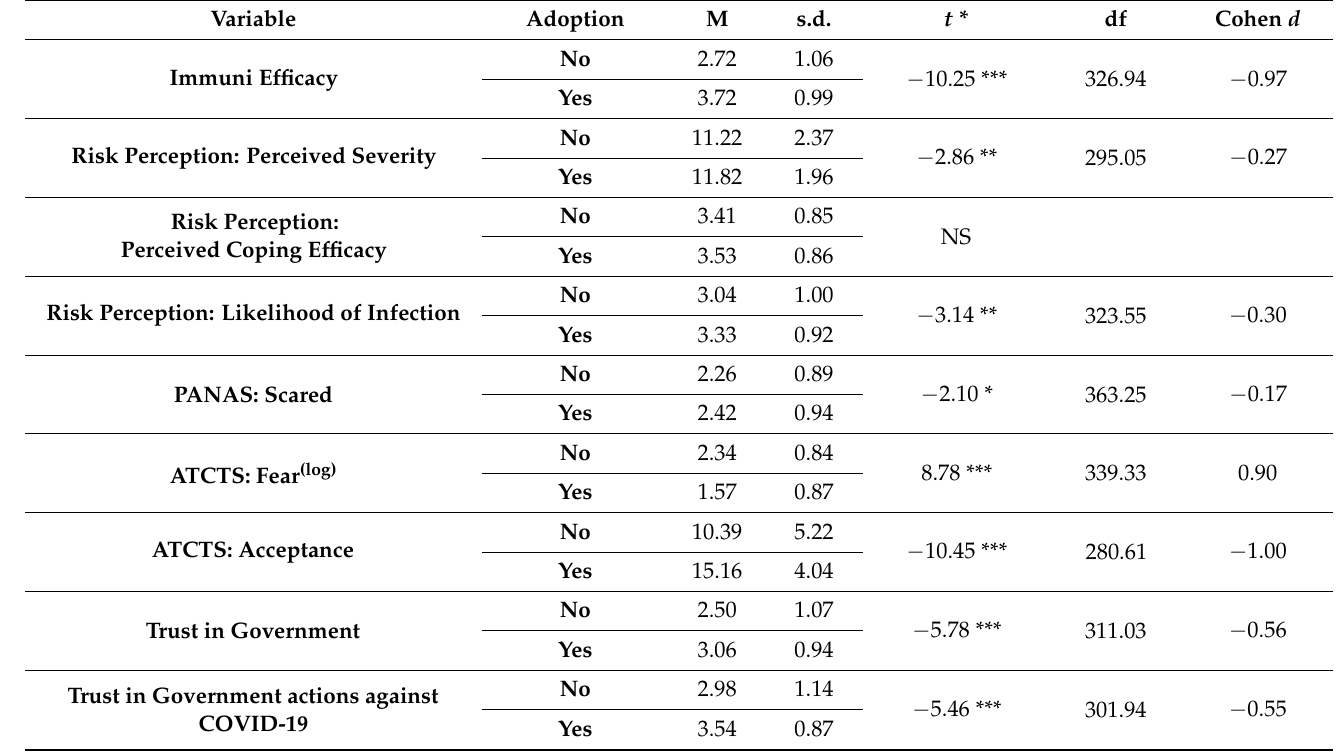
Table 1. Univariate analysis for Immuni adoption through Welch’s